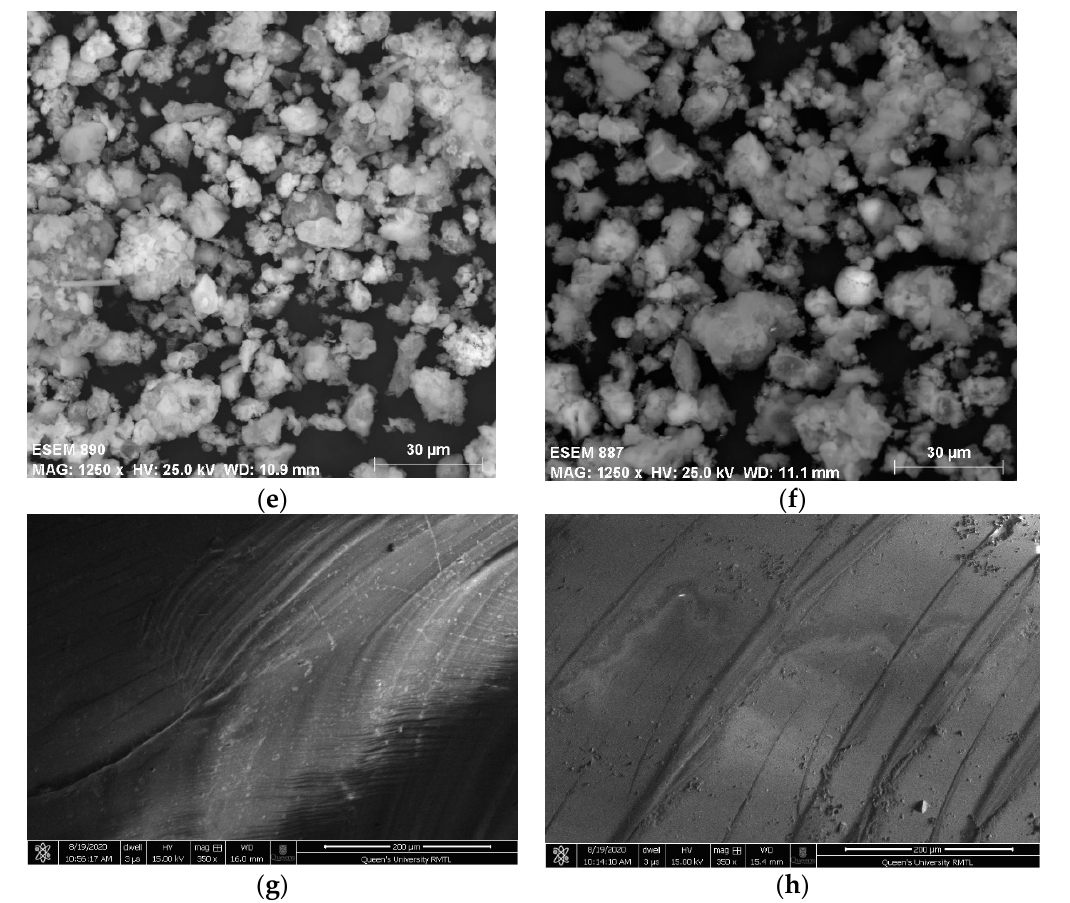
Figure 8. SEM images of ( a , b ) CF1, ( c , d ) CF2, ( e , f ) CF3, and ( g , h ) glass material before and after test 1315, respectively.